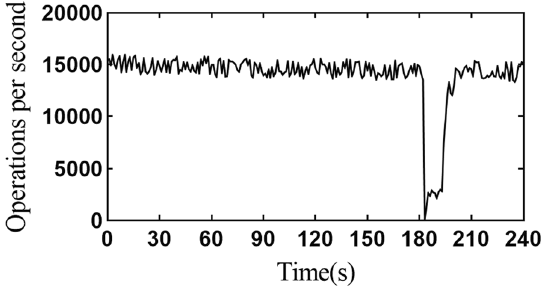
Fig. 11 Memcached service throughput rate